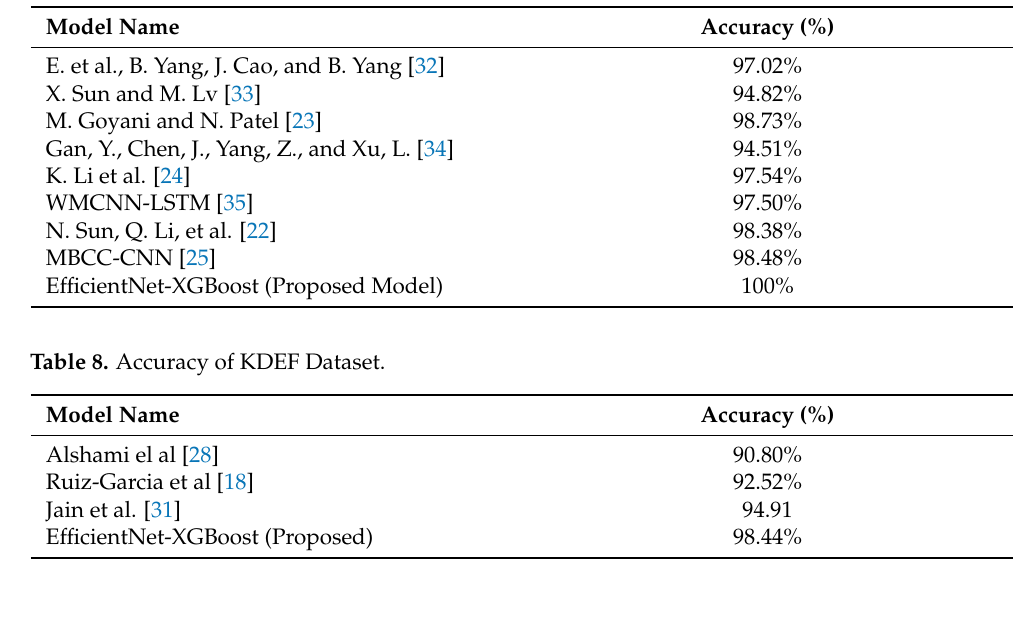
Table 7. Accuracy of CK+ Dataset.